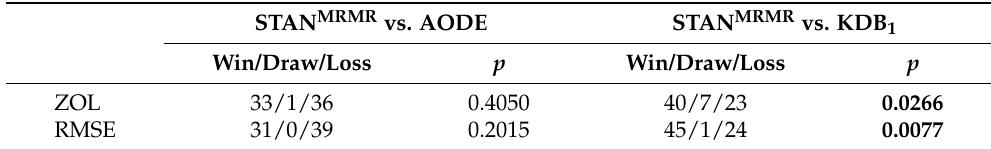
Table 3. Win/draw/loss records of STAN MRMR vs. AODE and KDB 1 in terms of ZOL and RMSE on 70 data sets.